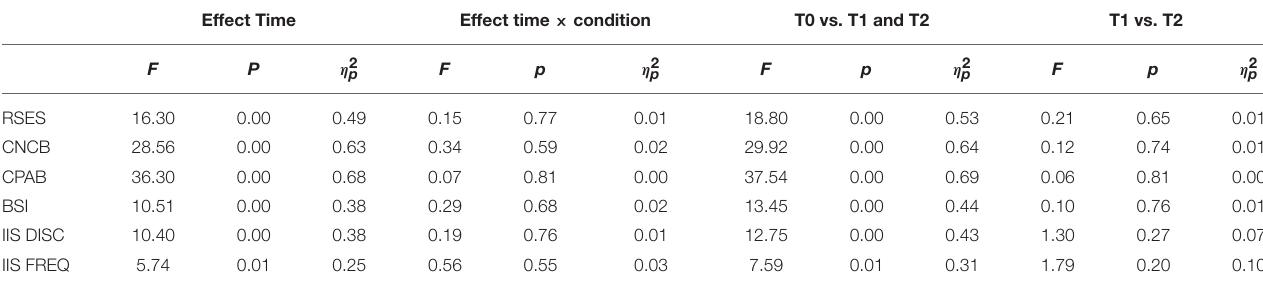
TABLE 3 | ANOVA analysis for the complete cases ( n 19). = Effect Time Effect time × condition